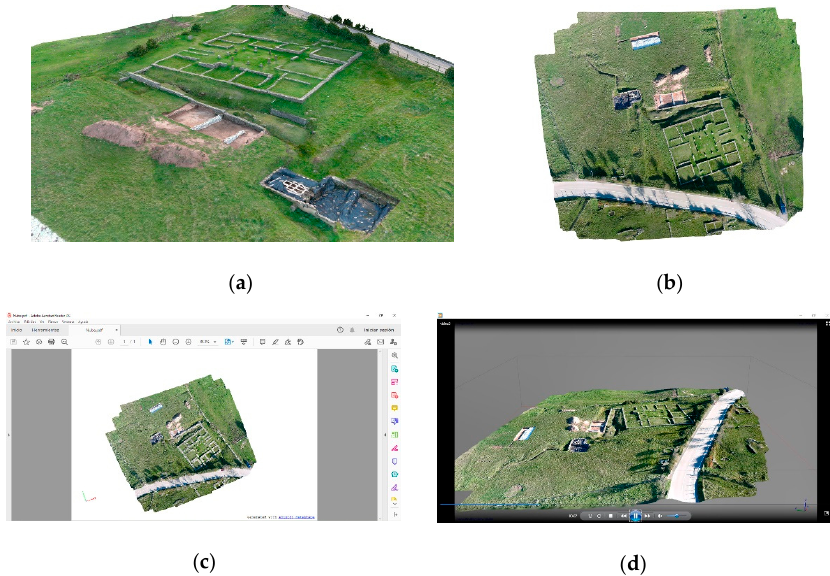
Figure 8. Graphic outputs obtained from the most accurate flight. ( a ) Texturized model. ( b ) Orthophotograph. ( c ) Interactive PDF. ( d ) Virtual itinerary.